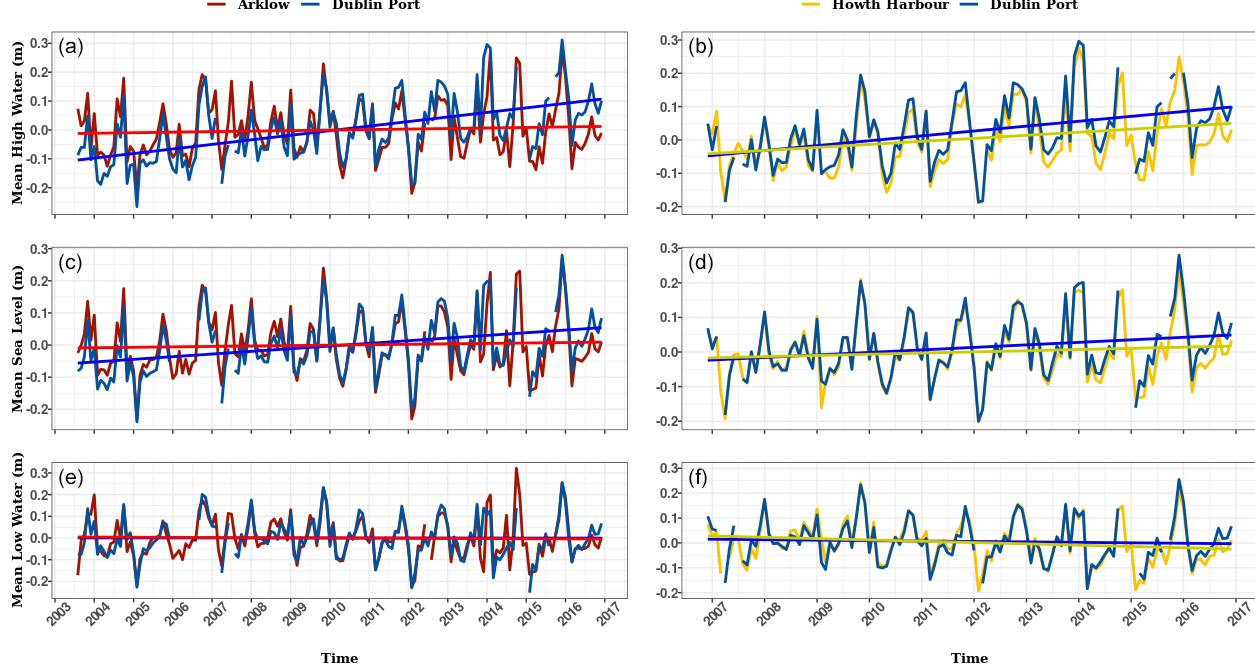
Figure 3. Comparison of MHW, MSL and MLW monthly values for Dublin Port against those for Arklow (a, c, e) and Howth Harbour (b, d, f) , with linear trends shown for each. The MLW linear trends for Dublin Port and Arklow are in good agreement, as are those for Dublin Port and Howth Harbour. However, this is not the case with the linear trends for MSL and MHW when comparing Dublin Port to the two other locations. Table 4. Details of the tide gauges installed at Dublin